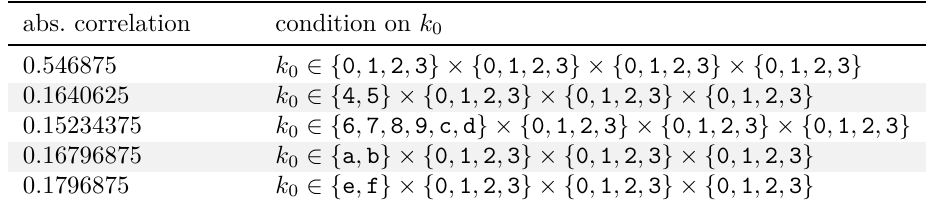
Table 4: Fixing the second round key k 1 = ( 0 , 0 , 0 , 3 ), this table shows all possible values for the absolute correlation of the approximation ( 8 , 8 , 8 , 8 ) → ( 8 , 8 , 8 , 8 ) over E G 00 , G for k 0 from the set of weak keys WK 00